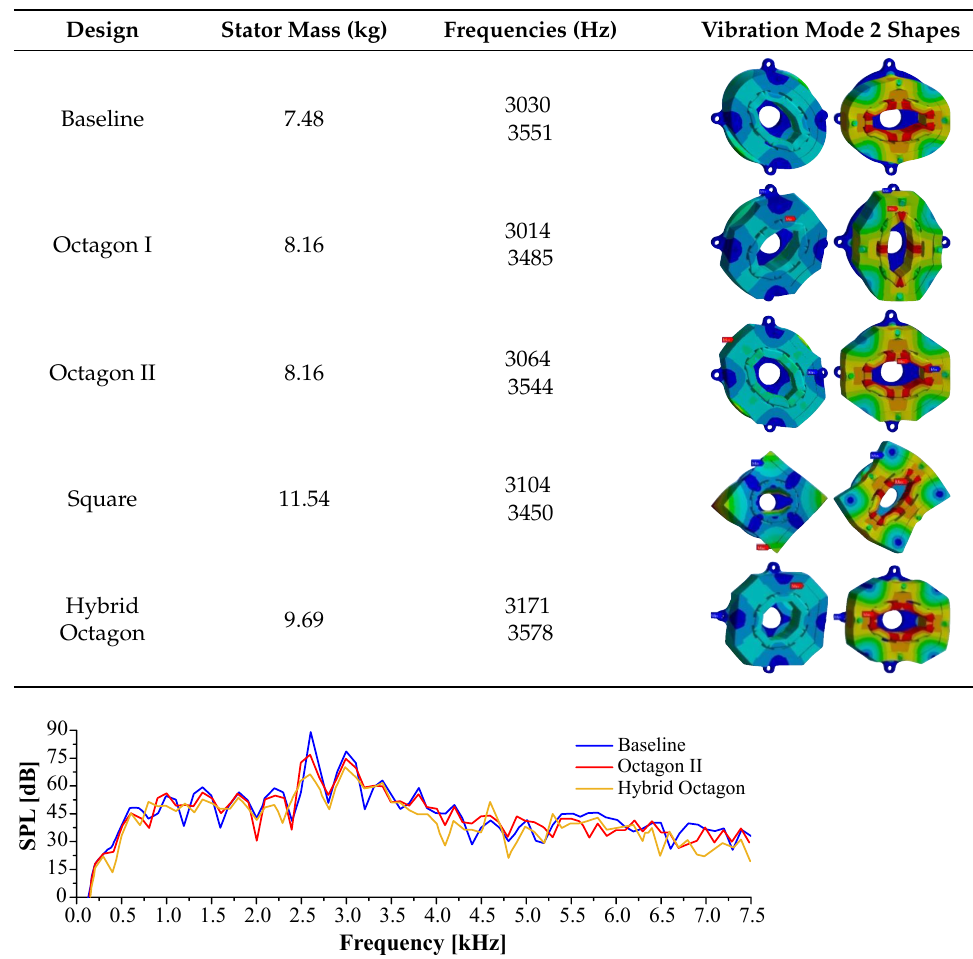
Table 5. Stator yoke designs and corresponding mode 2 natural frequencies.